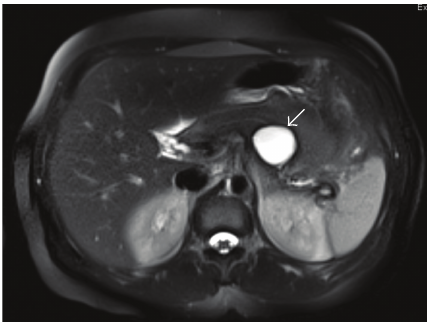
Figure 2: Mucinous cystic neoplasm (arrow) on MRI